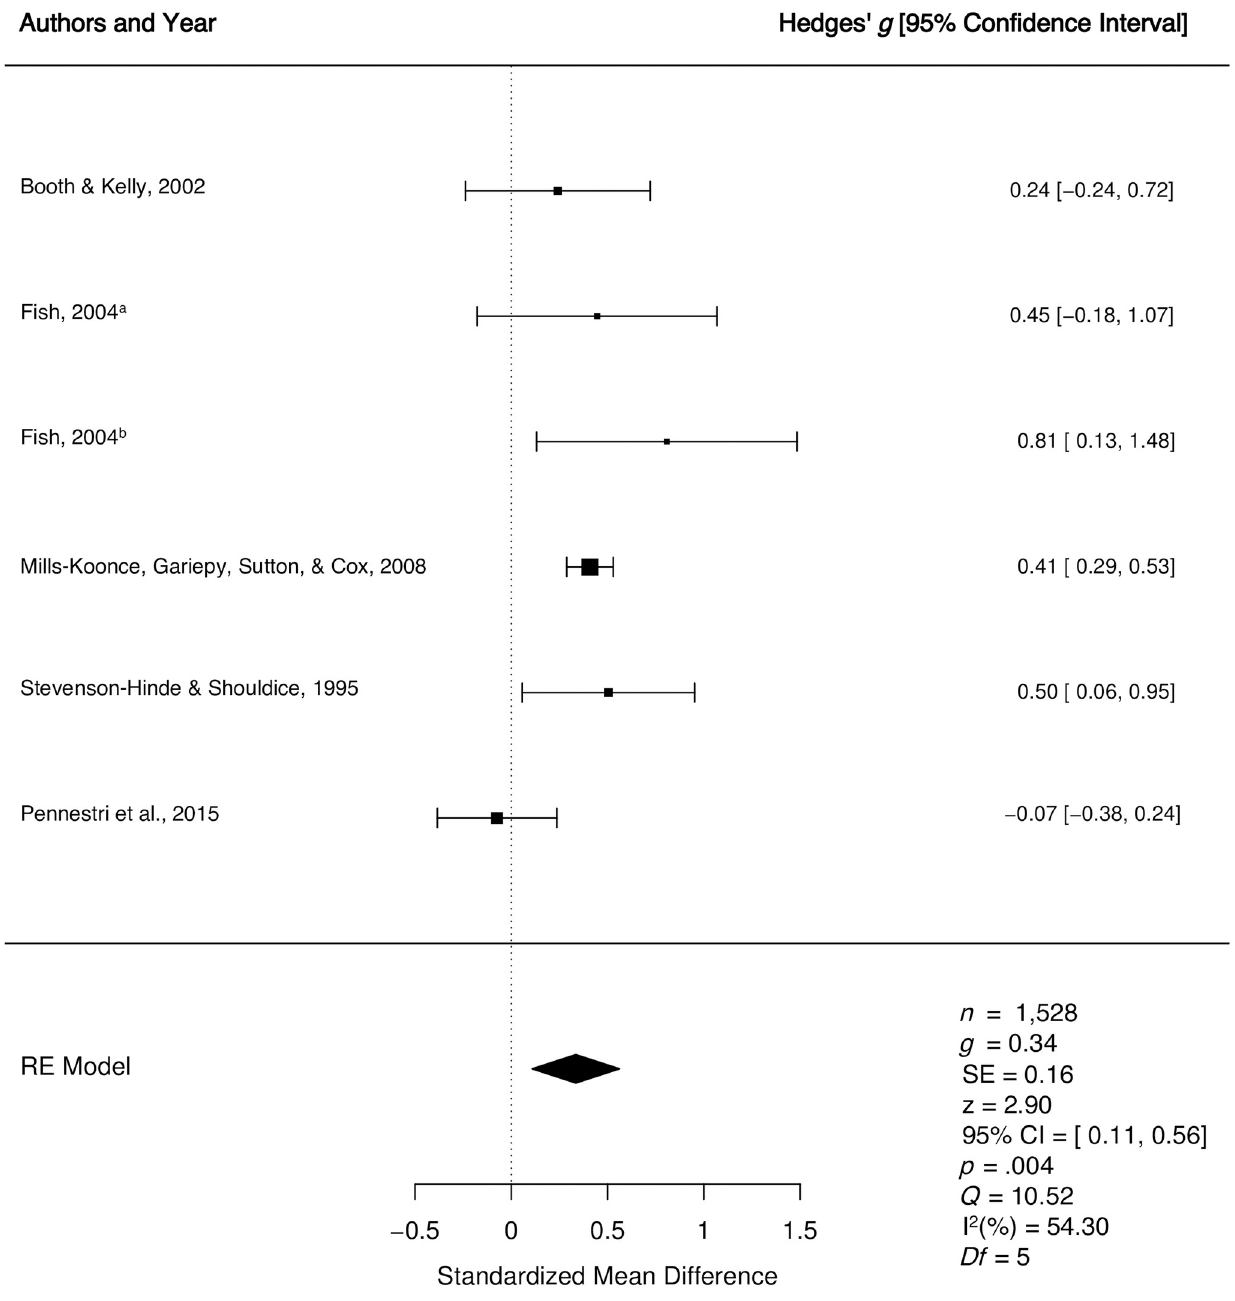
Fig 5. Forest plot for the longitudinal relationship between multidimensional caregiver sensitivity and secure versus insecure preschool attachment. RE = Random Effects Model; g = Hedges’ g; Q = Cochran’s heterogeneity statistic; I 2 = percentage of variability across studies that is due to between-study